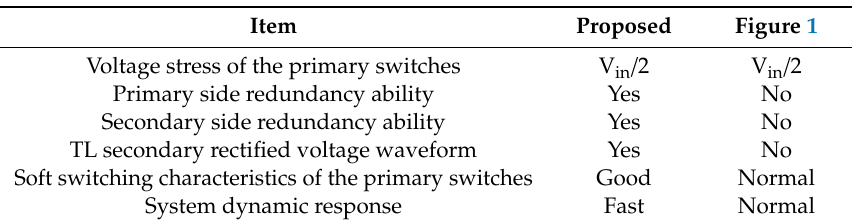
Table 8. Performance